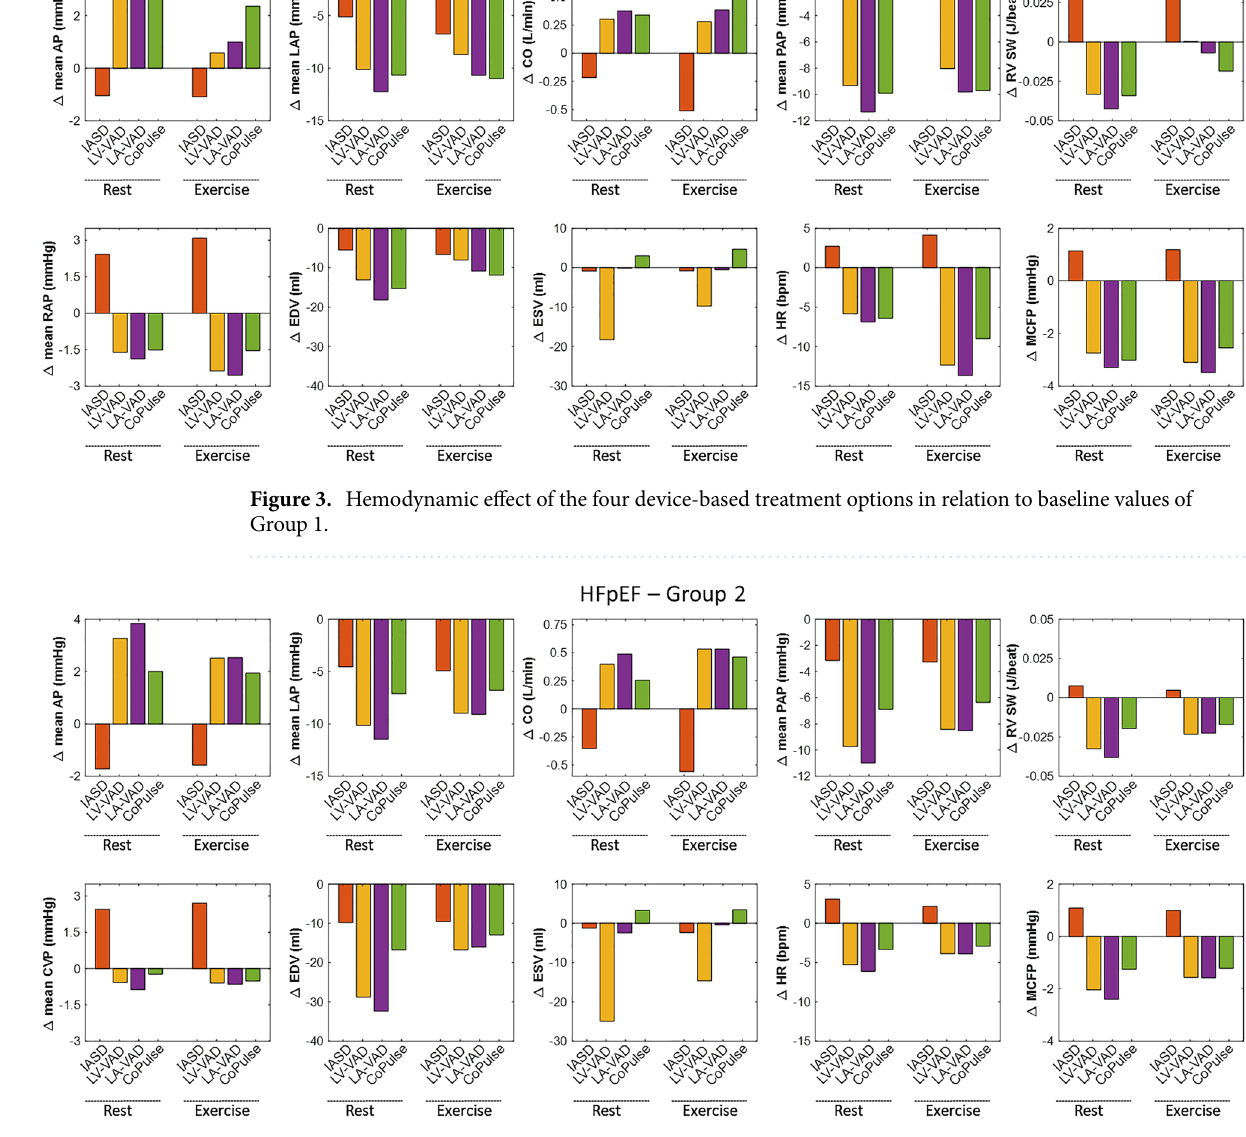
Figure 4. Hemodynamic effect of the four device-based treatment options in relation to baseline values of Group